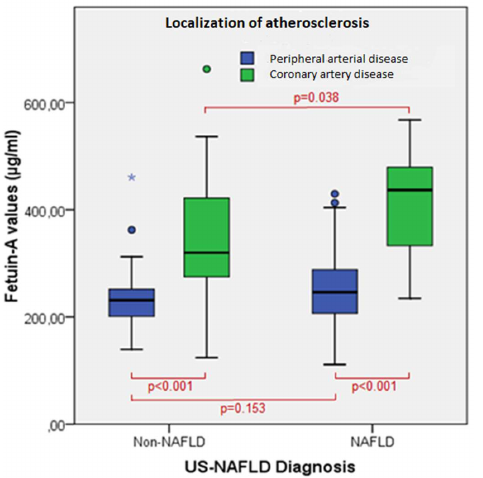
Figure 1. Fetuin-A values according to the presence of NAFLD and localization of atherosclerosis. Boxes represent the inter-quartile range and the line across the boxes indicates the median. The “whiskers” are the lines that extend from the box to the highest and lowest values, excluding outliers (dots and stars). The Mann–Whitney test was performed to compare medians. US = ultrasound. 3.4. Factors Associated with CAD (vs. PAD), NAFLD and Fetuin-A at Multivariate Analyses CAD (vs. PAD) was positively associated with Fetuin-A values (OR 1.02, 95% CI 1.01–1.02; p < 0.001) and negatively with NAFLD (OR 0.16, 95% CI 0.05–0.50; p = 0.002) (Table 2). Table 2. Multivariate analysis exploring factors associated with coronary artery disease (vs. peripheral arterial disease). Parameter OR (95% CI) p Fetuin-A *